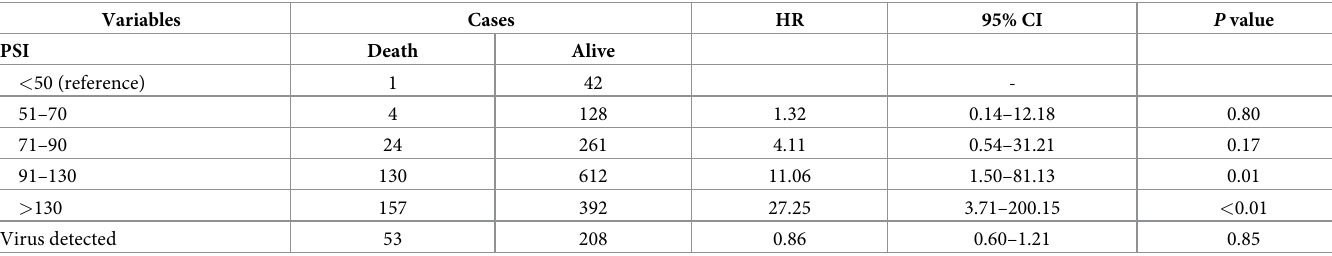
Table 3. Multivariate Cox regression analyses for 30-day all-cause mortality in community-acquired pneumonia.